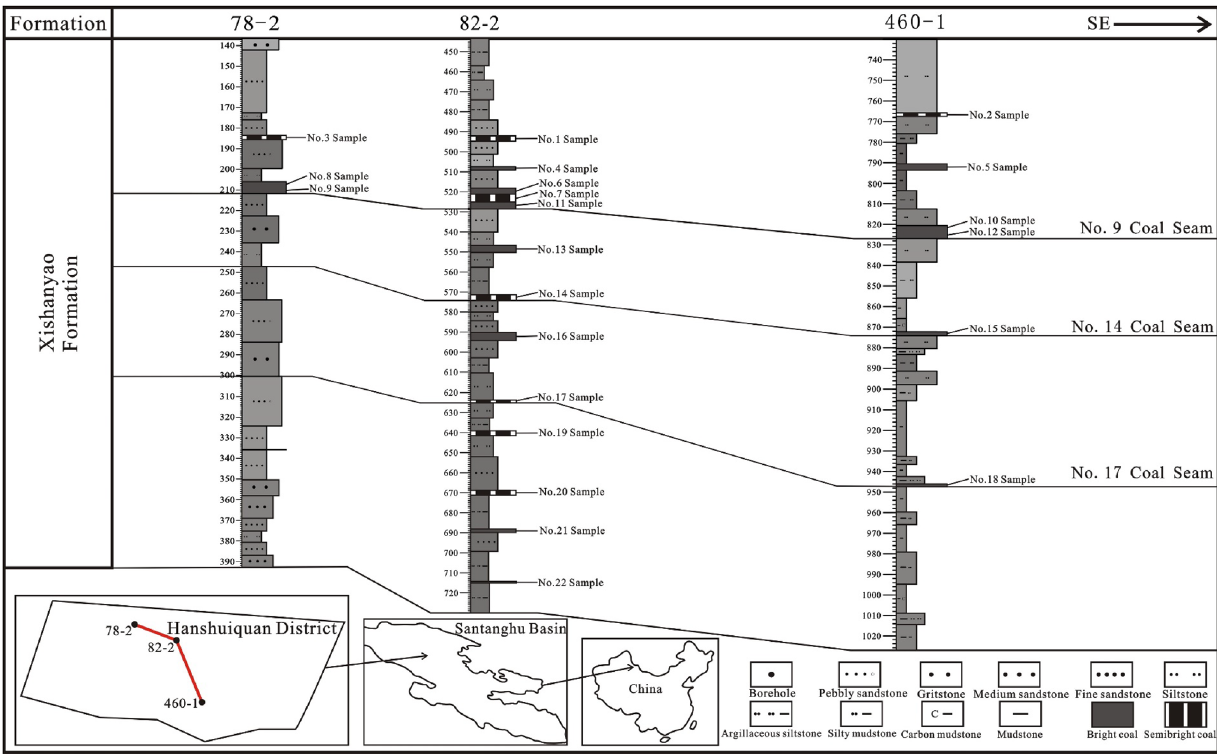
Fig. 3 The connecting-well section of 78-2, 82-2, 460-1 and the location of samples